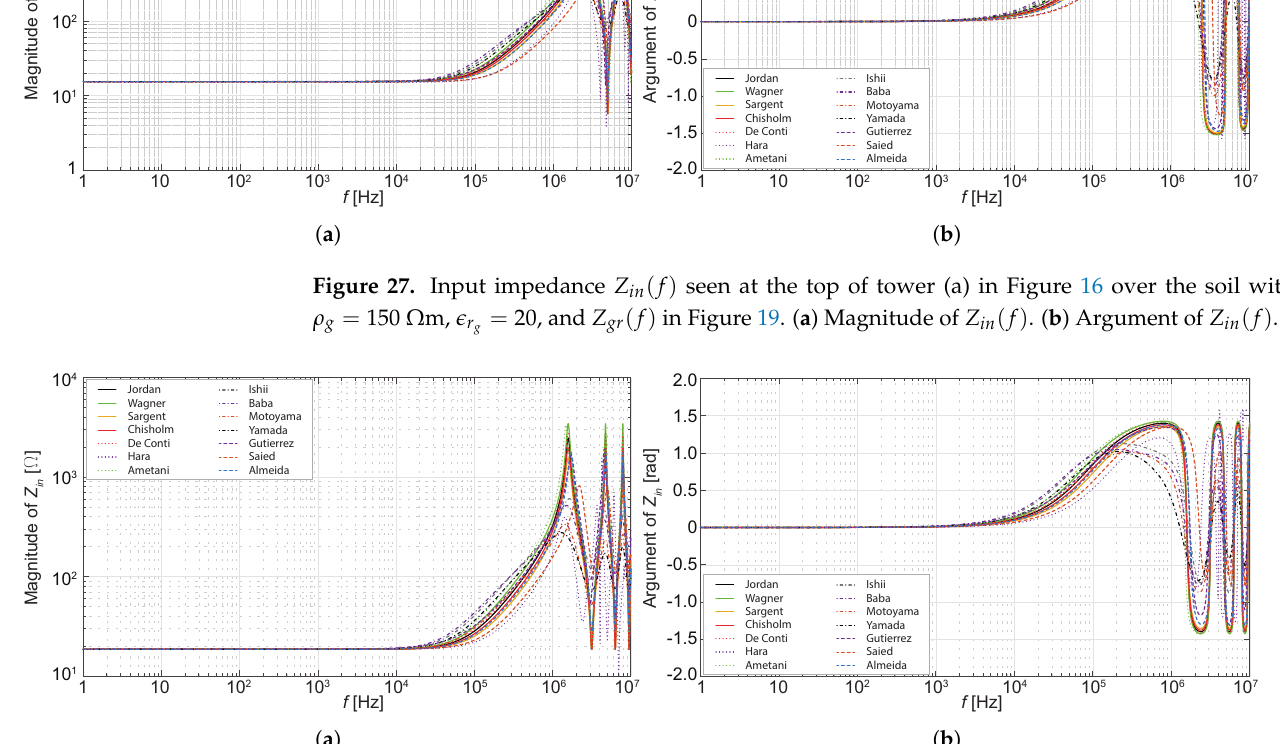
Figure 28. Input impedance Z in ( f ) seen at the top of tower (b) in Figure 16 over the soil with = 20, and R gr in Table 7. ( a ) Magnitude of Z ρ g = 600 Ω m, (cid:101) r g